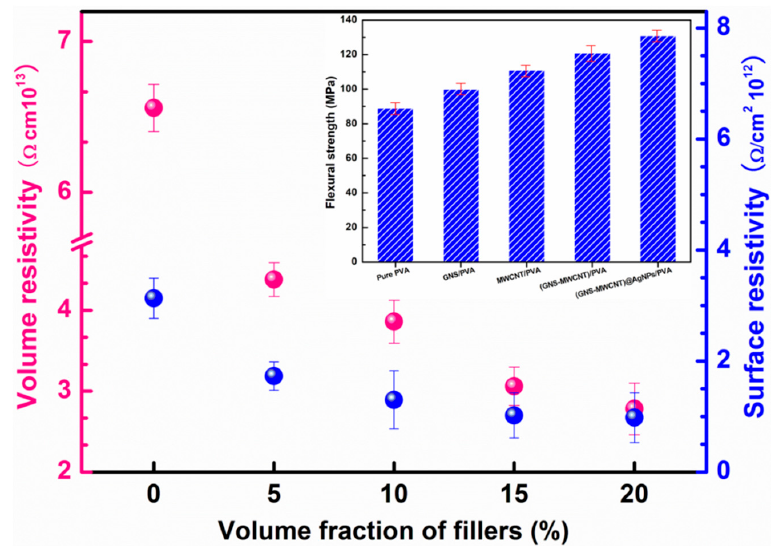
Figure 3. E ff ect of fi ller loading on volume resistance and surface resistance of (GNS- Figure 3. Effect of filler loading on volume resistance and surface resistance of (GNS-MWCNT) MWCNT)@AgNPs/PVA nanocomposite films, and effects of different fillers on the fl exural strength @AgNPs/PVA nanocomposite films, and effects of different fillers on the flexural strength of composites of composites compared with that of pure PVA matrix (inset). compared with that of pure PVA matrix Table 1. Glass transition temperatures, coe ffi cient of thermal expansion, and thermal decomposition temperature of pure PVA and its composites fi lled with GNS, MWCNT, and (GNS-MWCNT)@AgNPs at 5%, 10%, 15%, and 20% fillers loading.